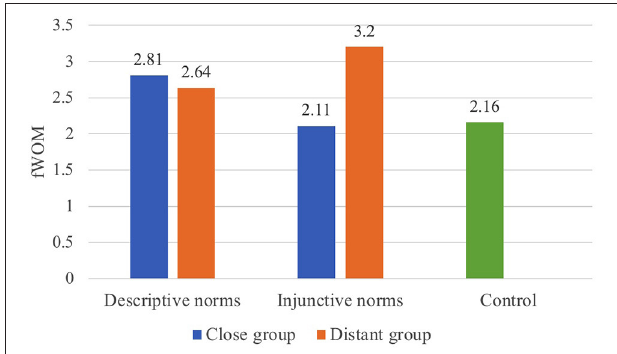
FIGURE 3 | The interaction of group distance and norms type on fWOM (Study